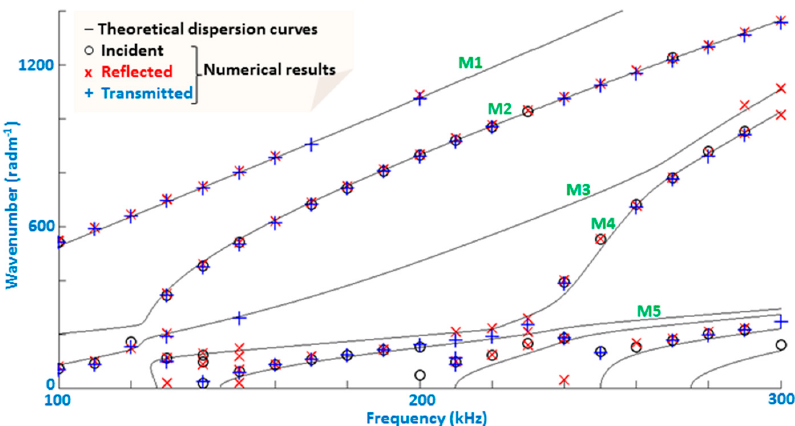
Figure 7. Locations of local maxima of the spatial Fourier transform of the incident (o), reflected (x) and transmitted fields (+) for a surface-originating crack type defect. Continuous black lines are the theoretical dispersion curves, plotted here to validate numerical results. The wavenumber is in absolute value to better compare which mode is which, even for reflected waves that in reality have a negative wavenumber [41].